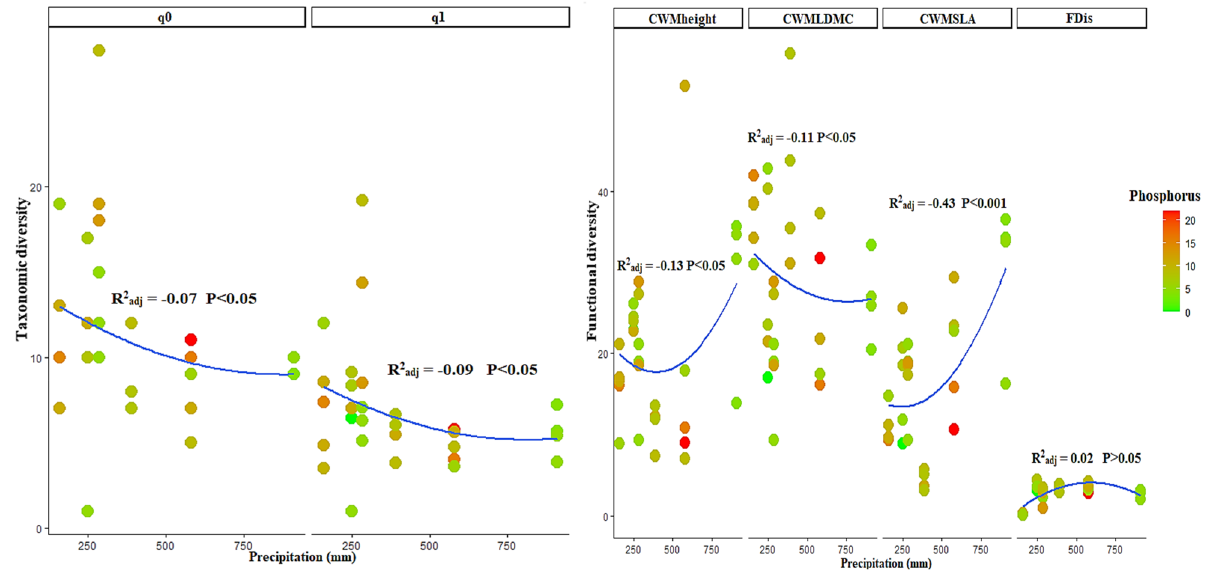
Figure 1. Variation in taxonomic (q 0 and q 1 in left panels) and functional (CWMheight, CWMLDMC, CWMSLA and FDis in right panels) diversity in rangeland sites across precipitation and phosphorus (P) gradients.